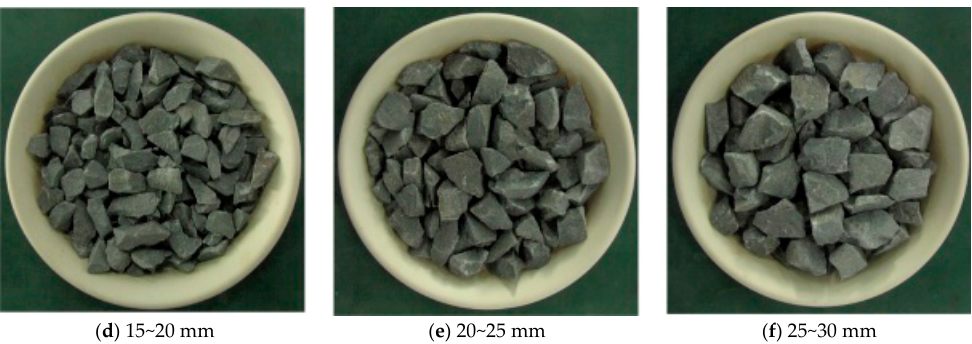
Figure 3. Crushed sandstone samples with different particle size distributions.